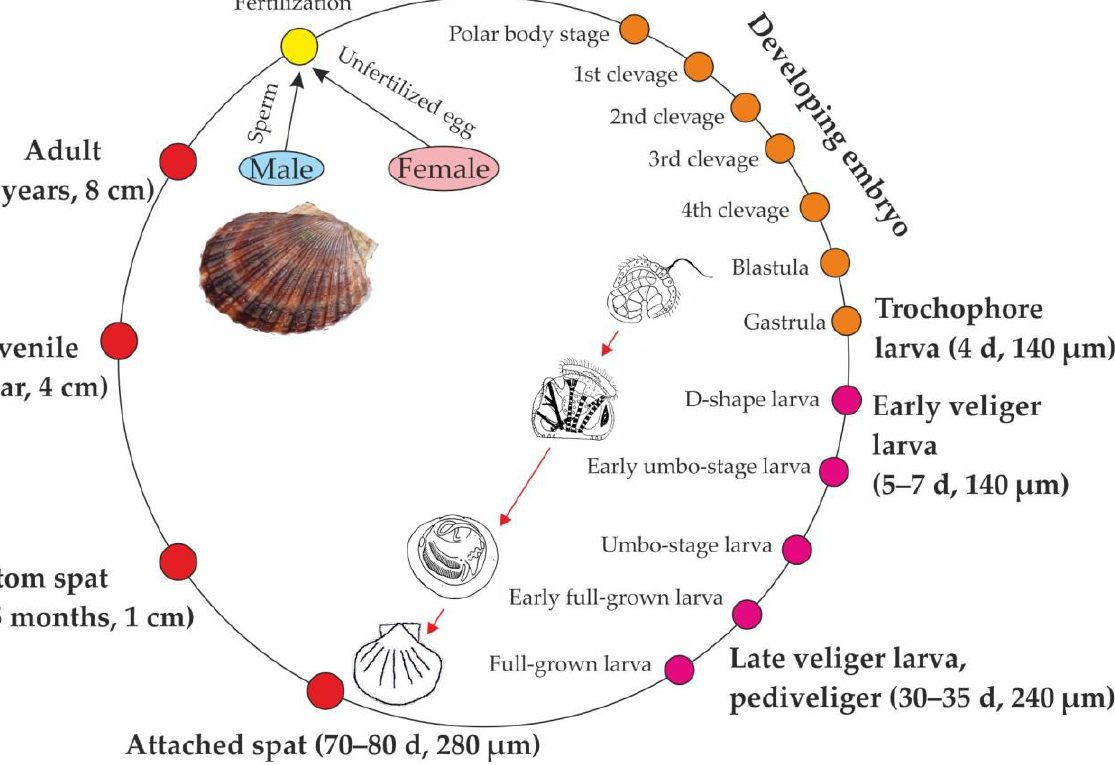
Figure 1. Life cycle of Mizuhopecten yessoensis in the Sea of Japan (modified from [3]). Usually, female fecundity varies from 25 to 30 million eggs but can reach 180 million eggs depending on size and age [28]. The initiation of spawning has been observed to